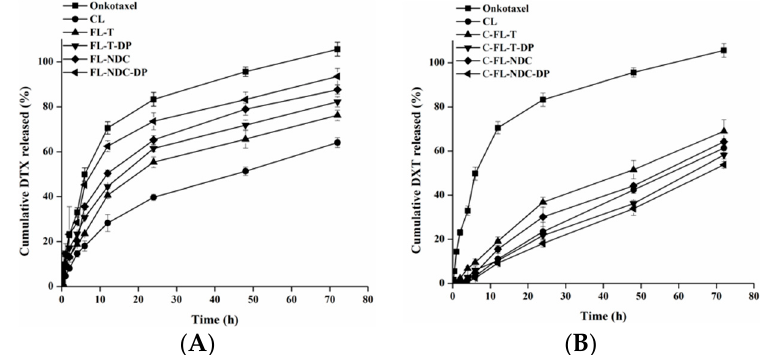
Figure 3. In vitro release profiles of DTX from Onkotaxel and liposomes ( A ) and chitosomes ( B ) in phosphate-buffered saline (PBS; pH 7.4) at 37 ± 0.5 °C. The data are expressed as means ± SD, n = 3.